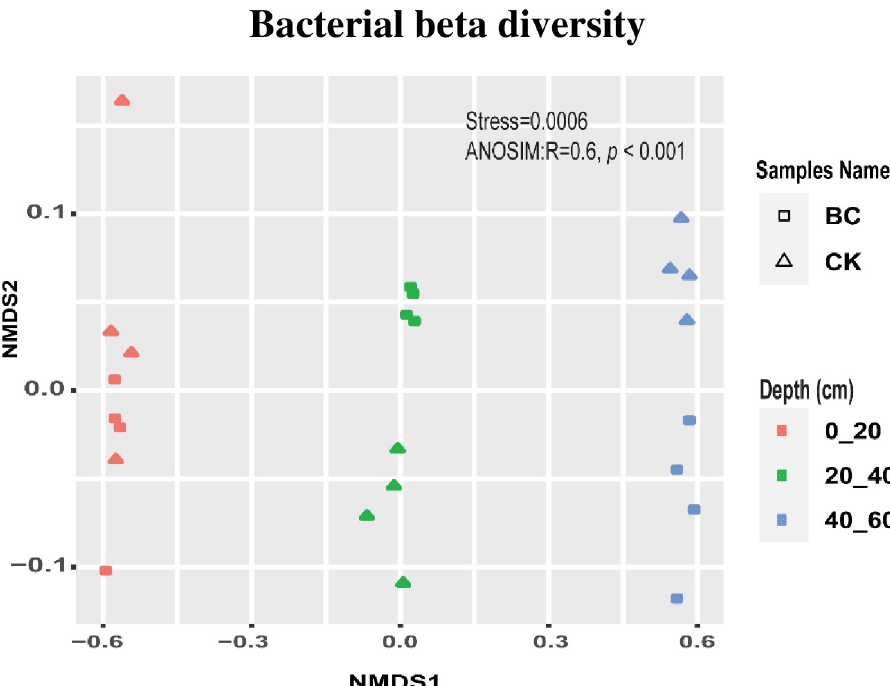
Fig 5. Analysis of nonparametric multidimensional scaling (NMDS) of the diazotrophic community structure in different soil depth. CK, control; BC, biochar amended soil.